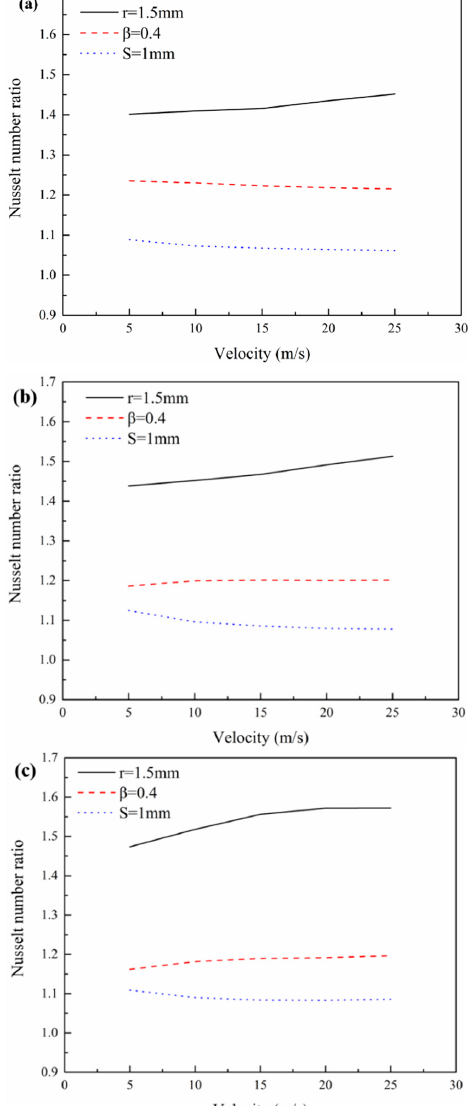
Figure 11. Nusselt number ratio versus the inlet velocity for three kinds of wavy fin with ( a ) γ = 0.38; ( b ) γ = 0.42; ( c ) γ = 0.45. f f , basic wavy